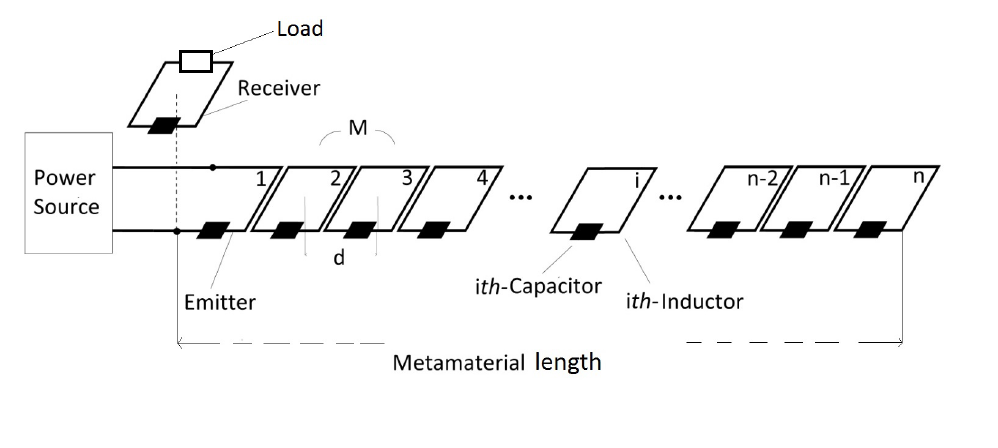
Figure 1. Metamaterial WPT system composed of n-coupled resonators arranged in a